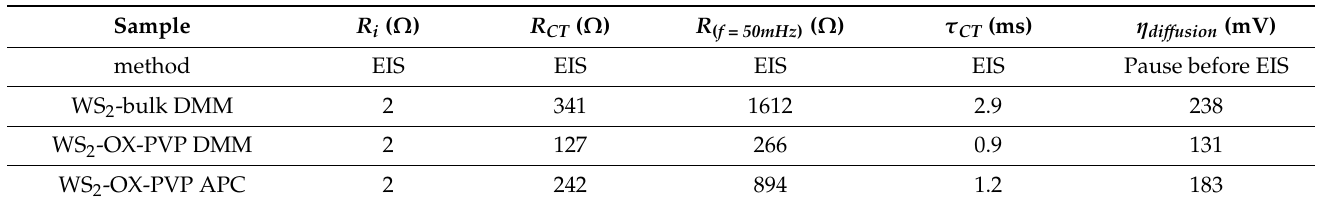
Table 1. Characteristic parameters from impedance spectra from EIS measurement and the relaxation voltage preceding EIS